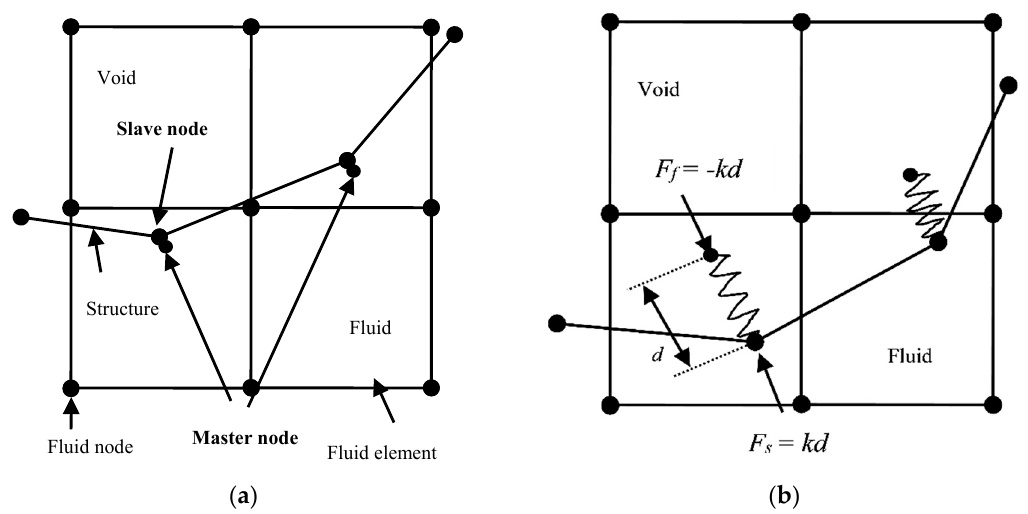
Figure 2. Sketch of the penalty function coupling algorithm: ( a ) at time t = t n ; ( b ) at time t = t n + Δ t